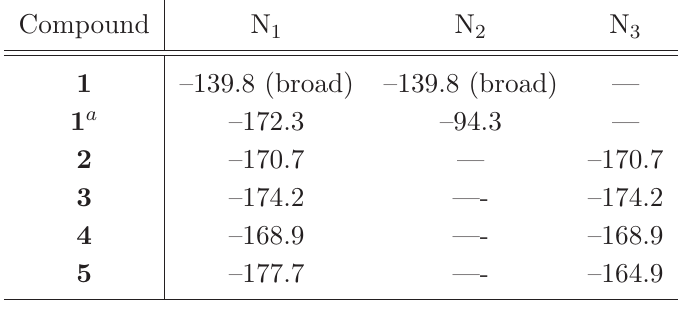
average and narrow indicating rapid N